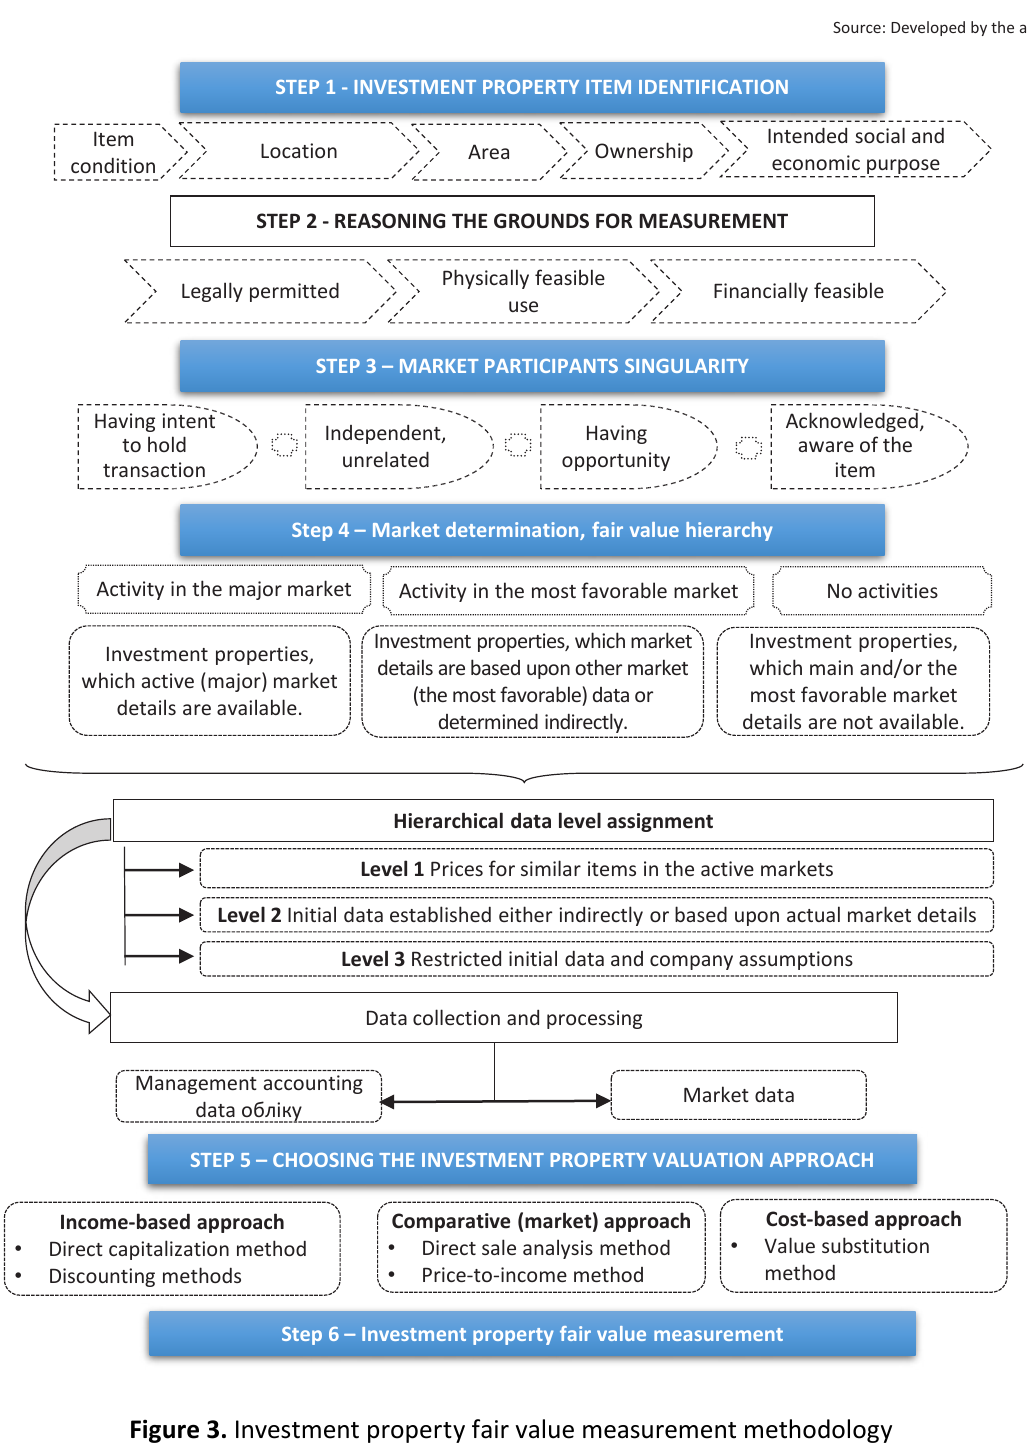
Figure 3. Investment property fair value measurement